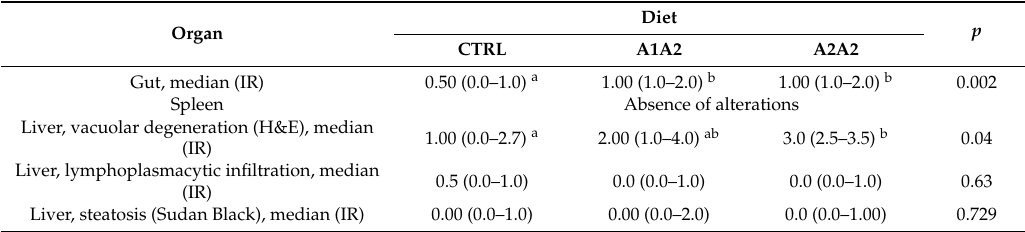
Figure 1. ( a ) Duodenum, A1A2 Mild and multifocal lymphoplasmacytic infiltration of the mucosa. Haematoxylin and eosin (H&E), 10×. ( b ) Duodenum, A2A2. Mild and multifocal lymphoplasmacytic infiltration of the mucosa. Haematoxylin and eosin (H&E), 10×. ( c ) Duodenum, CTRL. Mild and multifocal lymphoplasmacytic infiltration of the mucosa. Haematoxylin and eosin (H&E), 10×. ( d ) Ileum, A1A2. Mild and multifocal lymphoplasmacytic infiltration of the mucosa. H&E, 10×. ( e ) Ileum, A2A2. Mild and multifocal lymphoplasmacytic infiltration of the mucosa. H&E, 10×. ( f ) Ileum, CTRL. Mild and multifocal lymphoplasmacytic infiltration of the mucosa. H&E, 10×. ( g ) Duodenum, A1A2. Higher magnification of the lymphoplasmacytic infiltration in the mucosa. H&E, 20×. ( h ) Duodenum, A2A2. Higher magnification of the lymphoplasmacytic infiltration of the mucosa. H&E, 20×. ( i ) Duodenum, CTRL. Higher magnification of the lymphoplasmacytic infiltration of the mucosa. H&E, 20×. ( l ) Liver, A1A2. Moderate and diffuse vacuolar degeneration. H&E, 10×. ( m ) Liver, A2A2. Severe and diffuse vacuolar degeneration. H&E, 10×. ( n ) Liver, CTRL group. Mild and diffuse vacuolar degeneration. H&E, 10×. Table 4. Effect of dietary treatments on the histopathological scores of CTRL, A1A2 or A2A2 mice.